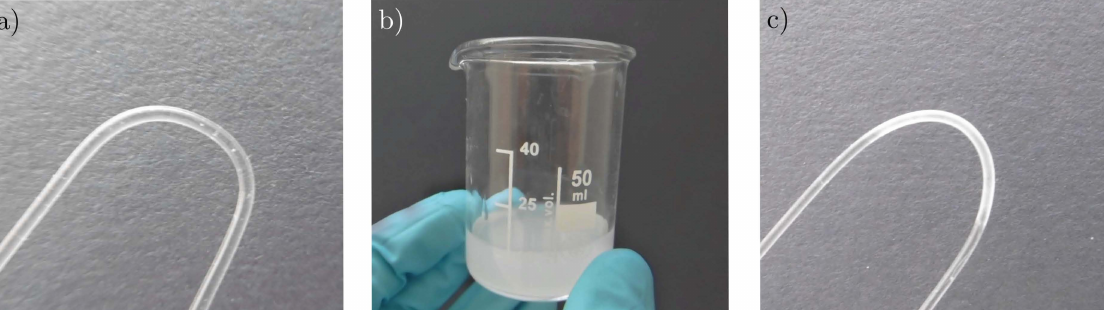
Figure 2. ( a ) The PMMA monofilament after being bent using a heat gun; ( b ) The poly- dimethylacrylamide (PDMAA)–ethanol solution; and ( c ) the coated monofilament after UV-curing.